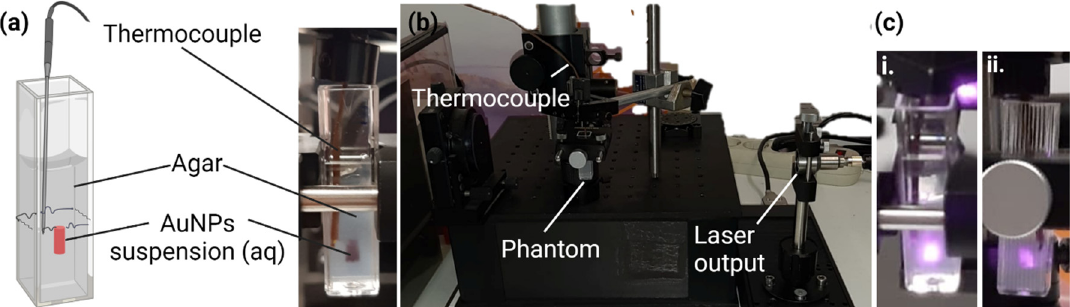
Figure 1. Experimental setup for studying the thermal activation of AuNPs. ( a ) Schematic and real representation of agar phantoms incorporating AuNPs; ( b ) Laser irradiation experimental setup; ( c ) Frontal ( i ) and lateral ( ii ) view of a representative phantom incorporating AuNPs during an irradiation process.